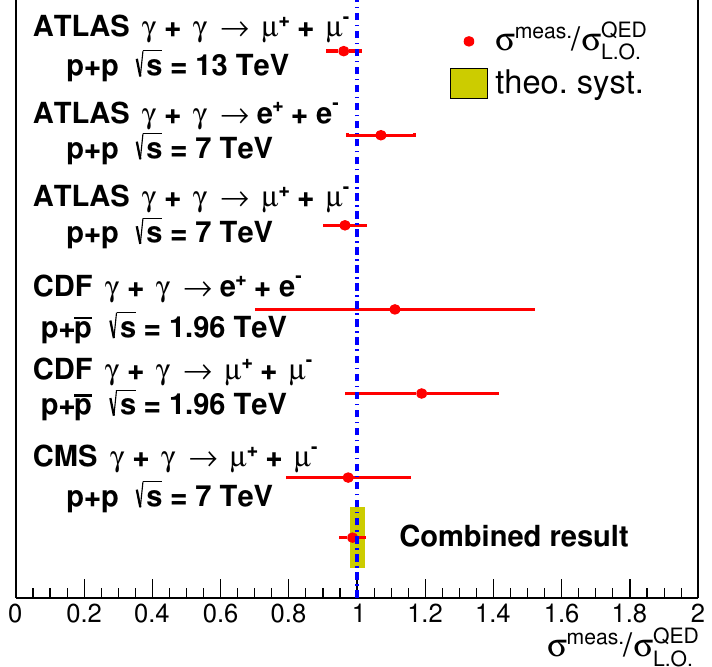
Figure 2 . (Color online) Comparison of the ratios of the measured cross sections from world-wide experiments [64–67] to the lowest order QED calculations for lepton pair production in p + p (¯ p ) collisions. The error bars represent the total uncertainties for the experimental measurements, which include the statistical and systematic errors. The yellow bands denote the uncertainties for lowest order QED